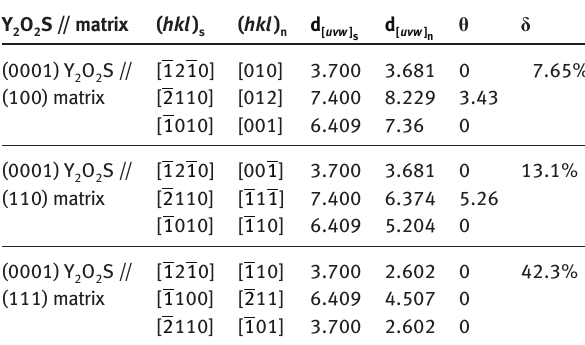
Table 3: Calculated values of lattice misfit between Y 2 O 2 S and γ -matrix Y 2 O 2 S // matrix